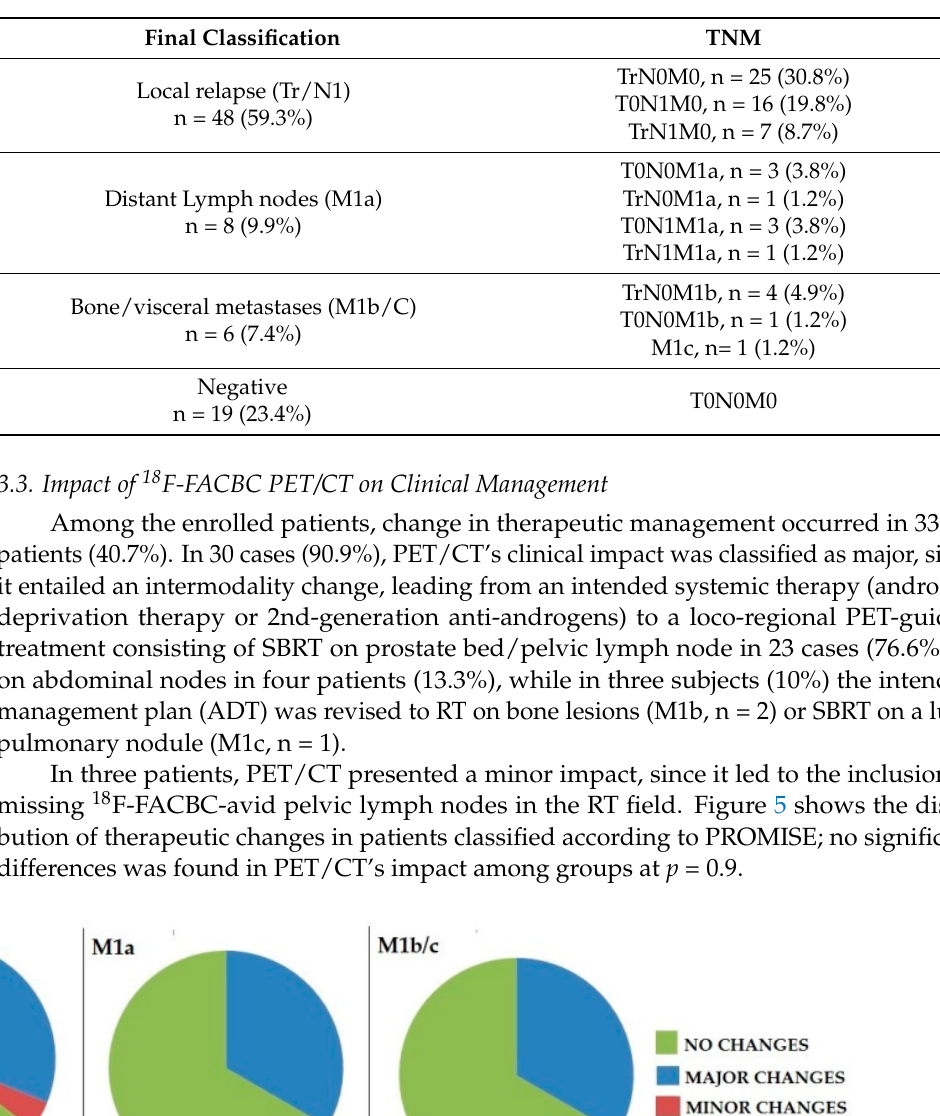
Figure 6. A 72-year-old patient 6 years post prostatectomy for pT3b pN0 ISUP Grade Group 4 prostate adenocarcinoma, presenting biochemical recurrence with PSA level prior to PET/CT of 0.38 ng/mL. ( A ) MIP image showing an area of increased tracer incorporation in the right pelvis (arrow). Fused corresponding PET/CT axial ( B , arrow) and coronal ( C , arrow) slices depicting a round-shaped right obturator lymph node, characterized by 18 F-FACBC pathological uptake, with a maximum diameter of 12 mm and a maximum standardized uptake value (SUVmax) of 7.7, su- perior to bone marrow SUVmean (3.1). Final diagnosis was T0N1M0 according to PROMISE. In- tended therapy prior to PET/CT was androgen deprivation therapy, after the collegial discussion of 18 F-FACBC PET/CT’s results, the patient was submitted to stereotactic radiotherapy with PSA re- sponse.